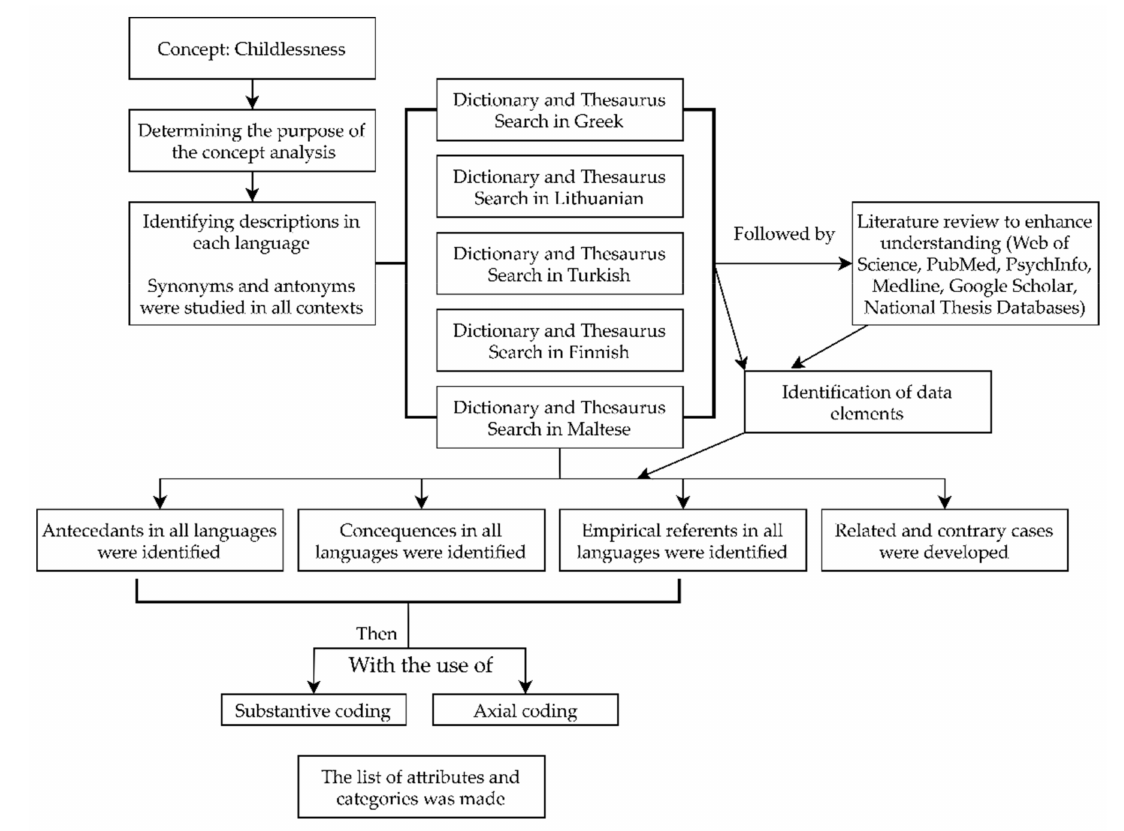
Figure 3. The stages of childlessness concept analysis (based on Walker and Avant’s